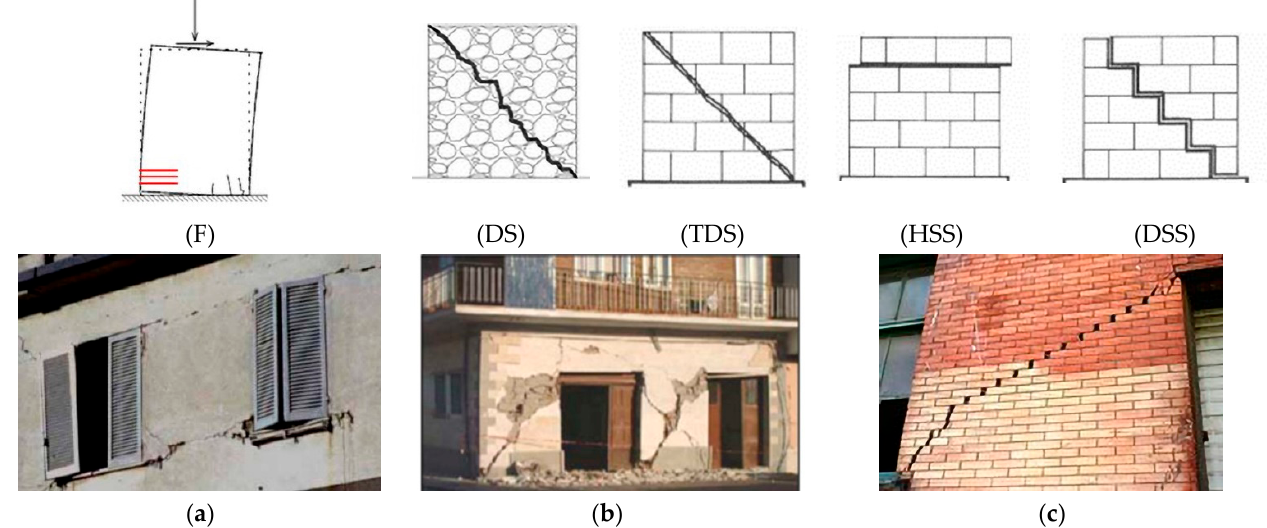
Figure 1. Typical failure mode in masonry panels: ( a ) flexural failure (F); ( b ) diagonal shear failure mode (DS or TDS); ( c ) sliding shear failure (HSS or DSS).